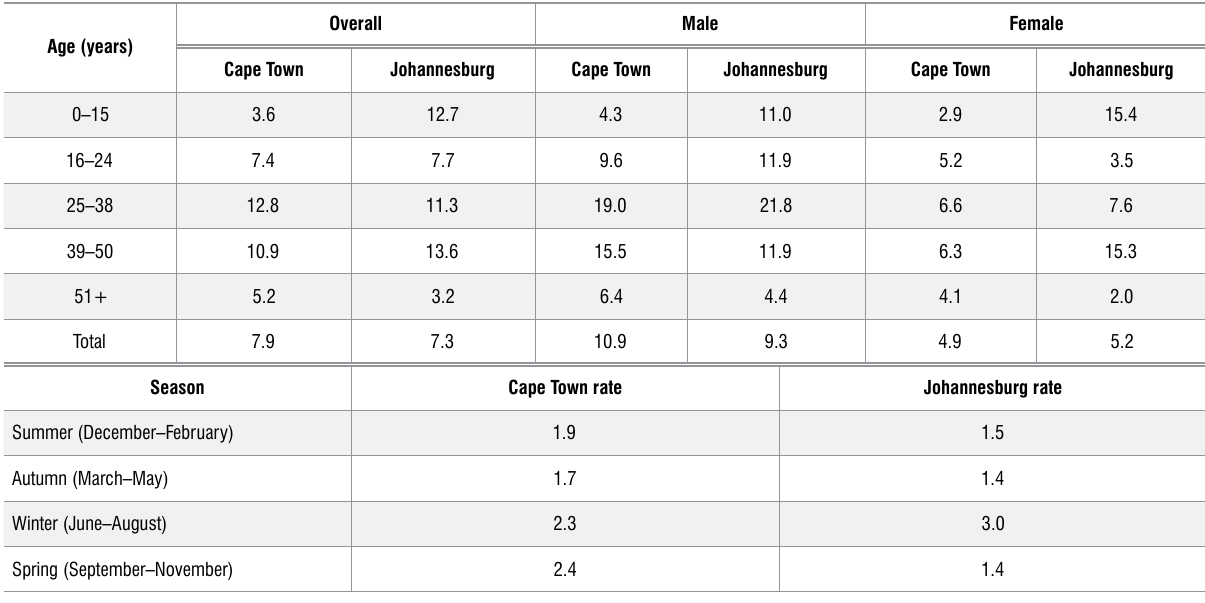
Comparison of year, population group, and sex burn mortality incidences between Johannesburg and Pretoria (adapted from Morobadi et al. 17 )